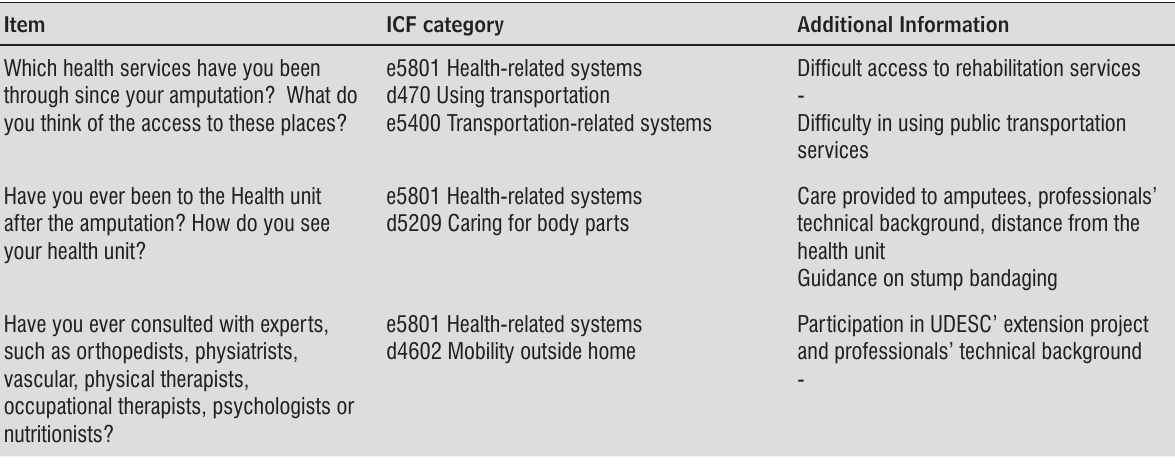
Table 1 - Description of ICF categories based on the Interview Script